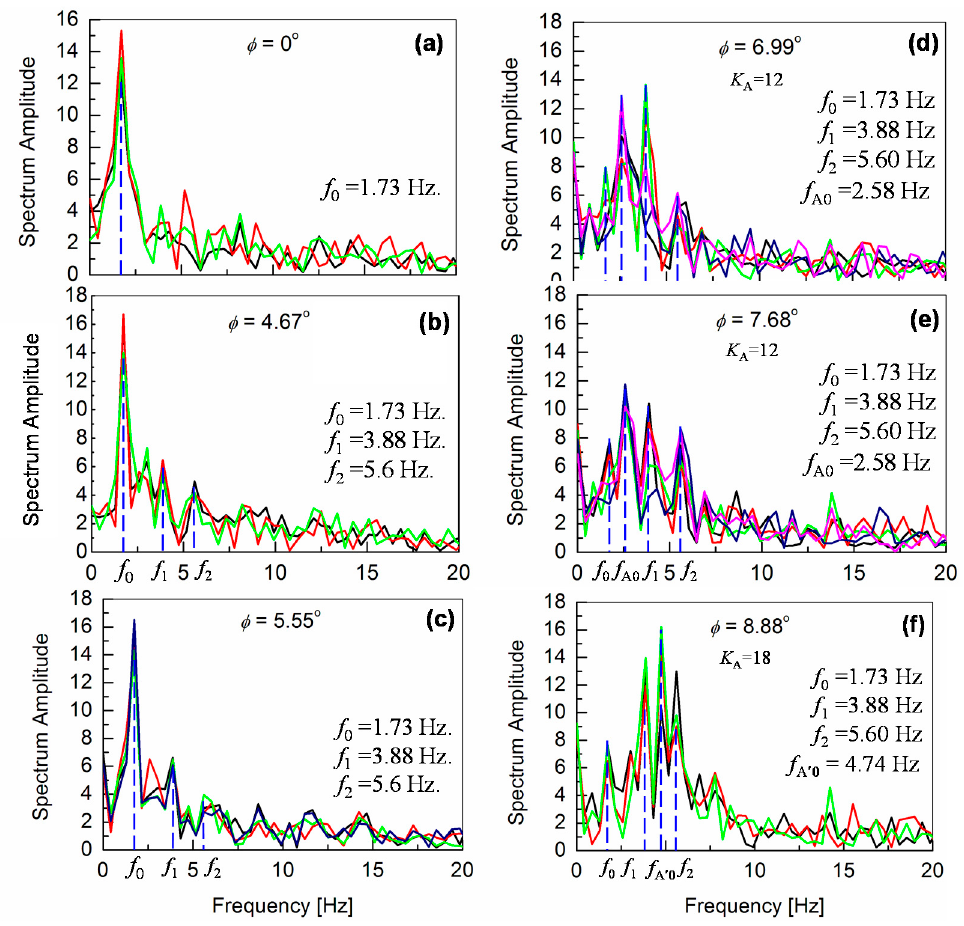
Figure 8. Fourier analysis of the angular-pitch velocity waveforms measured by the gyro sensor for the robot-body, when the robot is walking stably on inclined surfaces without (( a ), ( b ), ( c )) and with (( d ), ( e ), ( f )) gyro-sensor feedback. The frequency f A0 = 2.58 Hz (see ( d ) and ( e )) is induced by the motor feedback with K A = 12, which is shifted to f A’0 = 4.74 Hz (see ( f )) due to an increased K A . Further explanations are given in Section 5.1.